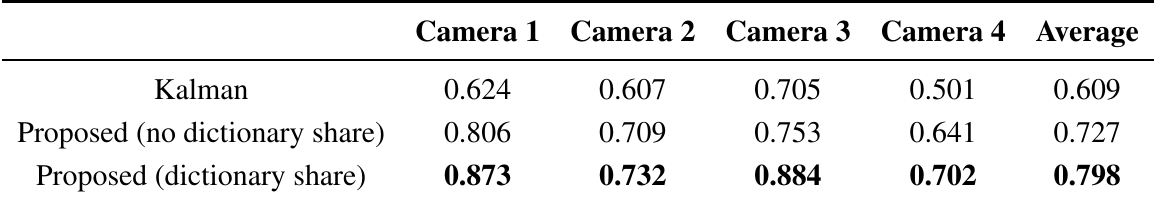
Table 3. The lifecycle of different methods. The best results are in bold